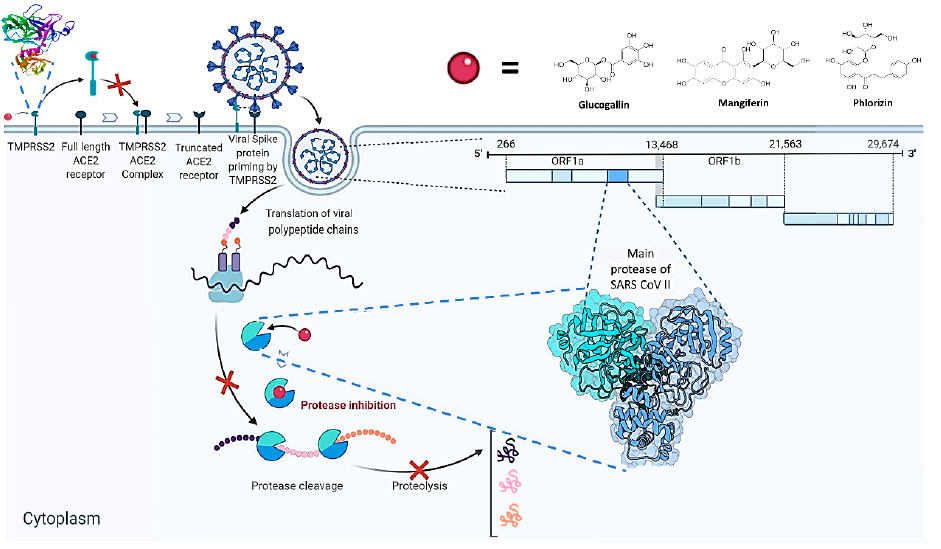
Figure 7. Hypothetical illustration of the anti-SARS-CoV-2 activity of the three polyphenolic Figure7. Hypotheticalillustrationoftheanti-SARS-CoV-2activityofthethreepolyphenoliccompounds. compounds.